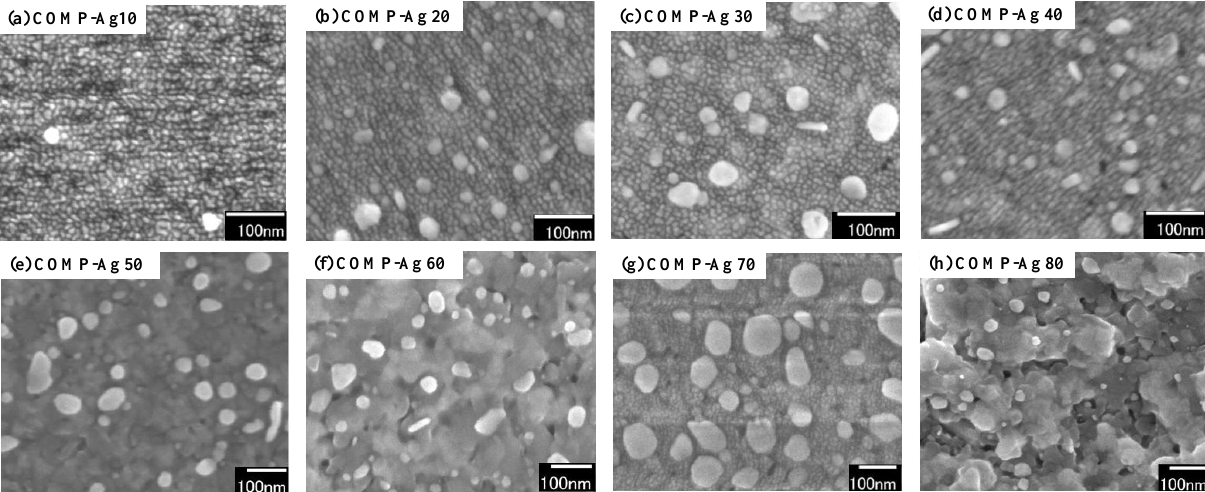
Figure 4. SEM images a-h, of the Ag-NP/TiO molar concentrations: ( a ) 10; ( b ) 20; ( c ) 30; (b) 40; ( e ) 50; ( f ) 60, ( g ) 70 and ( h ) 80, respectively.